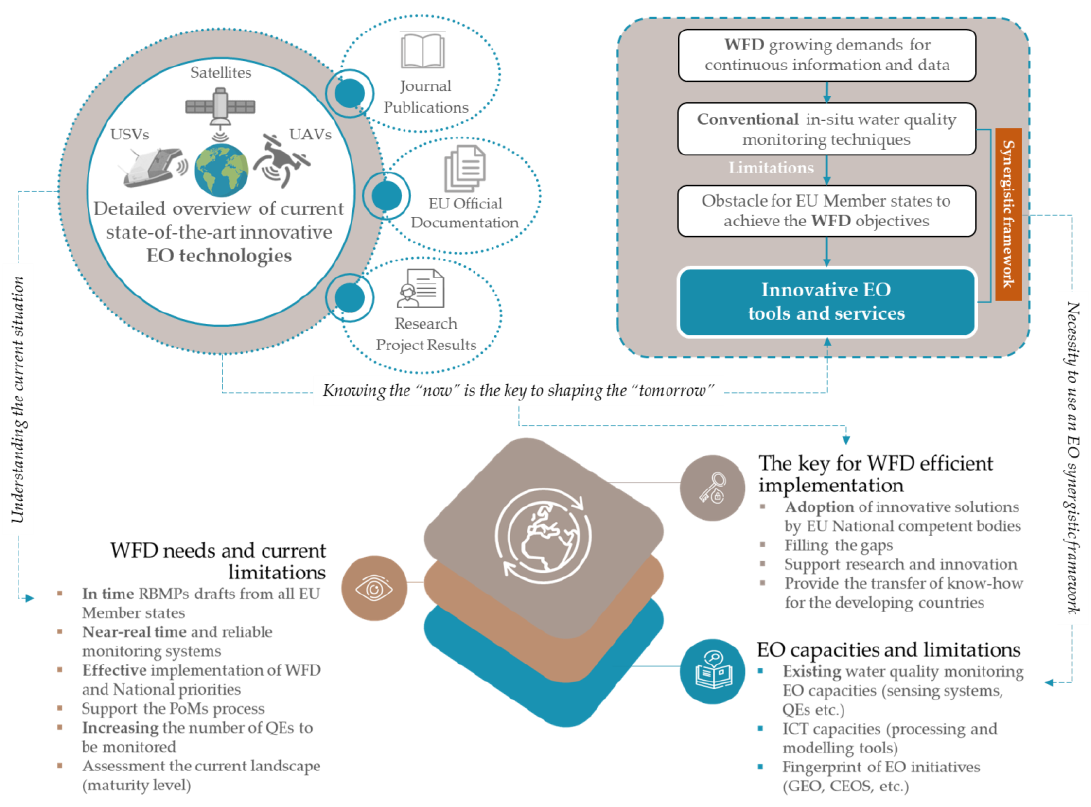
Figure 1. The methodological approach adopted in this work.